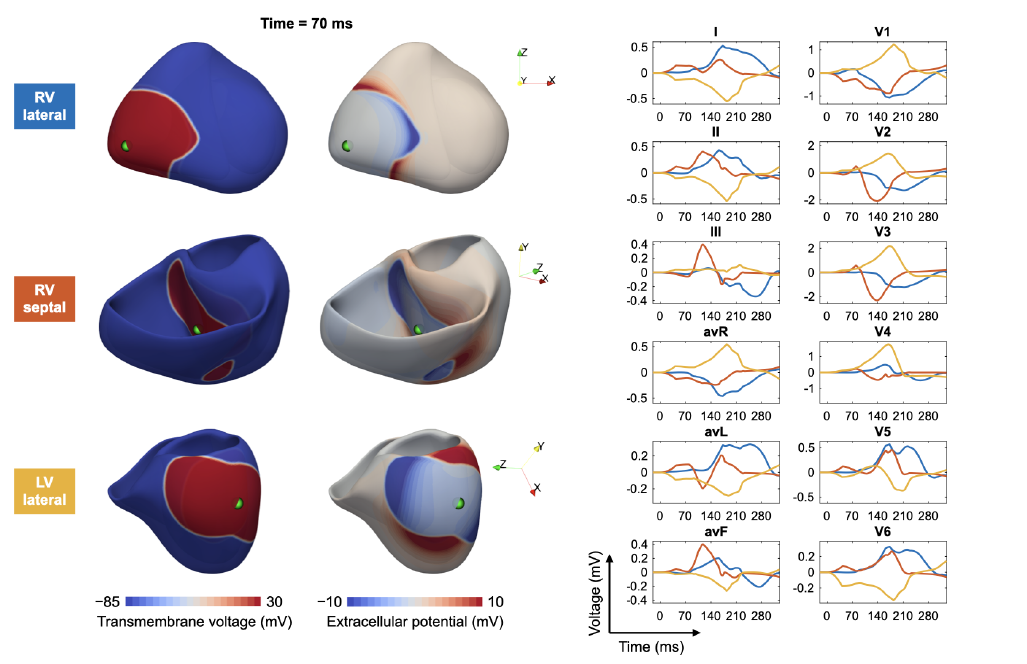
Figure 3. Modeling of ectopic beats and the corresponding ECG: for three different trigger locations in the right ventricle (RV) and left ventricle (LV), the transmembrane voltage ( left column ), the extra- cellular potentials ( middle column ) and corresponding ECGs ( right column ) are shown. Excitation propagation was computed by solving the anisotropic Eikonal